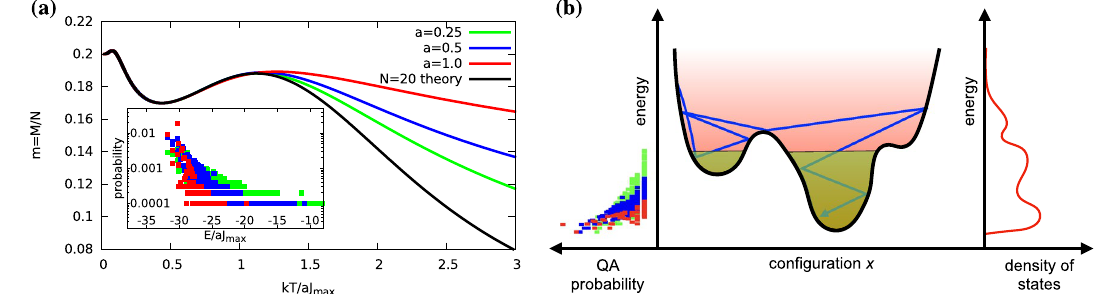
Figure 1. Mean magnetization and probability distribution of a spin glas and sampling strategy. ( a ) The plot shows the temperature dependent magnetization of an N = 20 random coupling spin glass. The QA sampled values coincide with the theoretical results in the low temperature regime, whereas for elevated temperatures the energy rescaling factor a affects the quality of the results. The probability for getting a state x , which is estimated using 10,000 repetitions of the sampling, depends to good approximation only on its energy E ( x ) and follows essentially a Boltzmann distribution, as shown as inset. Different rescaling factors a > 0 shift the distributions to higher or lower energies. ( b ) Illustration of the different sampling strategies. The blue trajectory illustrates the Markov chain generated by the Metropolis algorithm to generate a Boltzmann probability distribution (red shading). Alternatively, the Wang-Landau approach constructs the density of states, from which thermodynamic properties can be predicted. In contrast, the QA approach identifies low energy configurations (green shading), which are taken as most representative fraction of the phase space for low temperature expectation